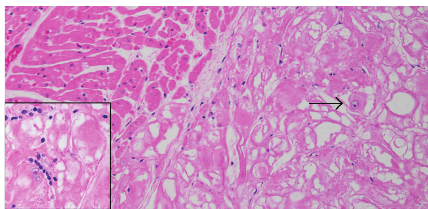
Figure 2: Heart; bearded seal. Neoplastic cells are large and vacu- olated and occasional spider cells are also observed (arrow) and rare foci of lymphocytes are present (insert). H&E.